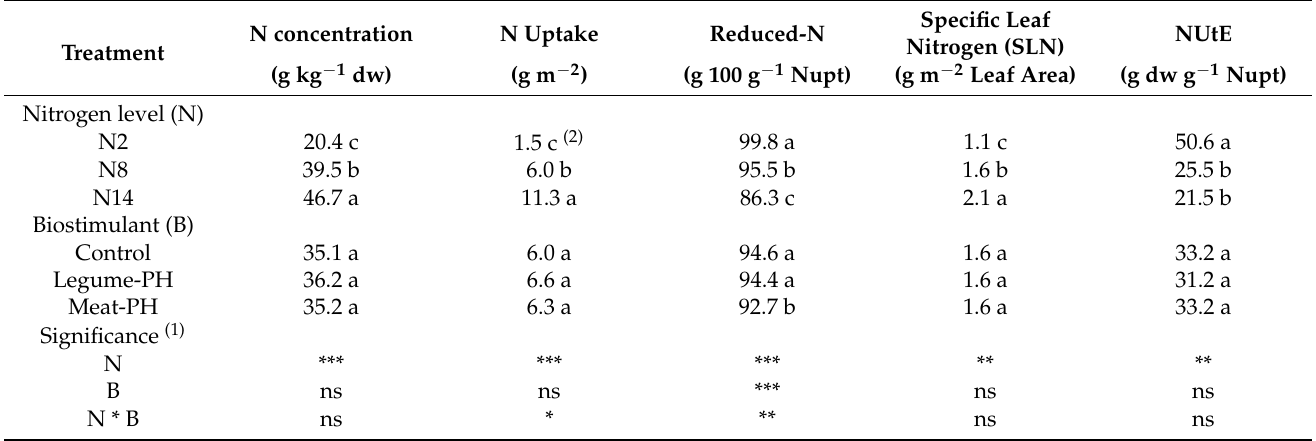
Table 4. Indices of nitrogen nutrition status and of nitrogen utilisation efficiency (NUtE) of spinach leaves as affected by nitrogen nutrition and by foliar application of biostimulants.